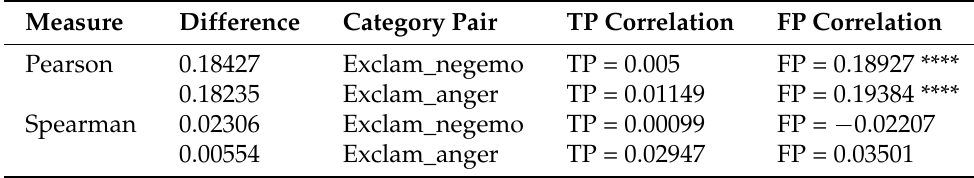
Table 14. Exclamations and Negative emotions/Anger in Suicidal.